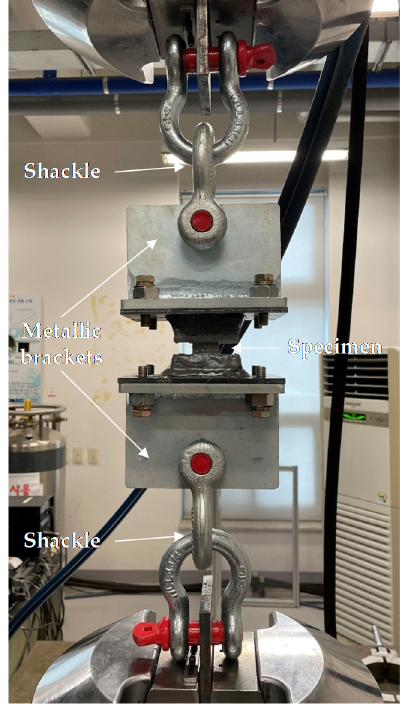
Figure 10. Interlayer bond strength test.